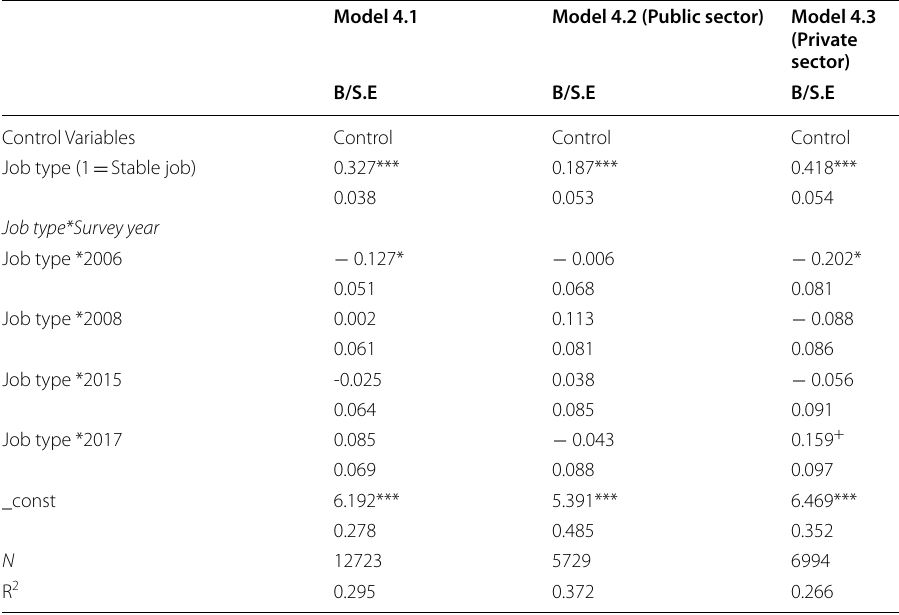
Table 5 Regression analysis of the change of job type on working income